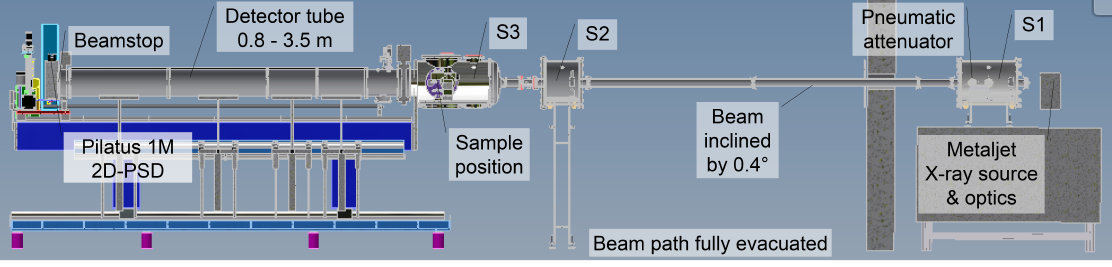
Figure 1: Schematic drawing of GALAXI with its main components. The beam direction is from right to